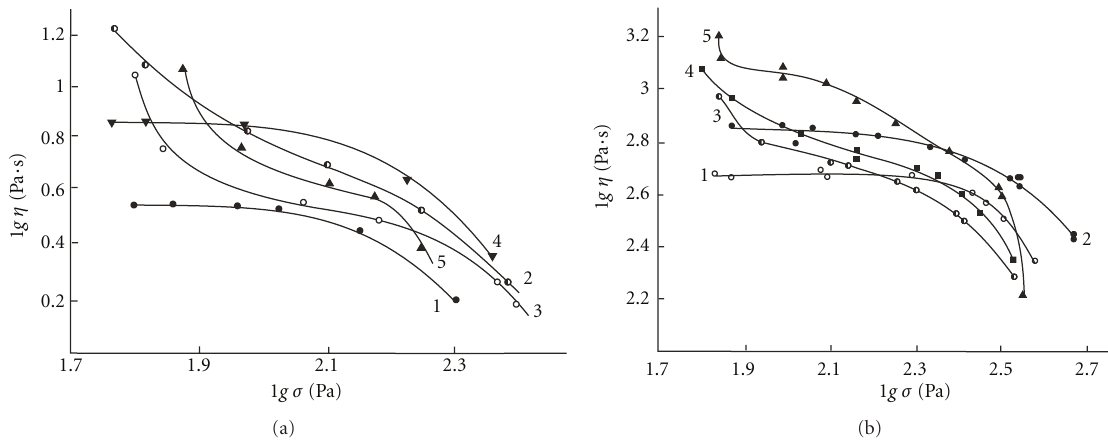
Figure 7: Flow curves of the CTA-nitromethane system with polymer concentrations of (a) 6 wt% at T = 60 ◦ (1), 43 ◦ (2), and 35 ◦ C (3), and 8 wt% at 60 ◦ (4) and 40 ◦ C (5). The duration of thermostatting, 1h; (b) 13wt% at 50 ◦ (1), 45 ◦ (2), 38 ◦ (3), 30 ◦ (4), and 25 ◦ C (5), the duration of thermostatting 1h (1, 2), 2h